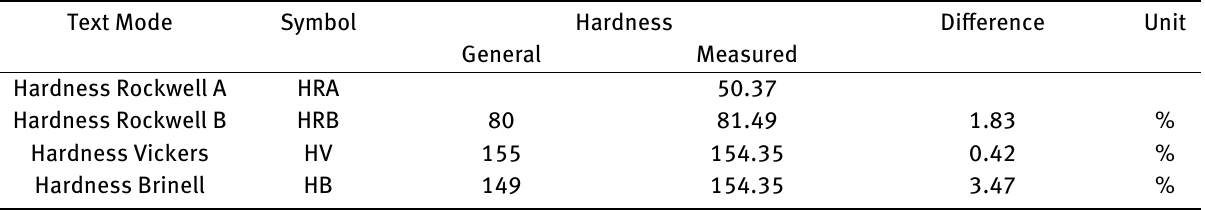
Table 2: Hardness testing results. Text